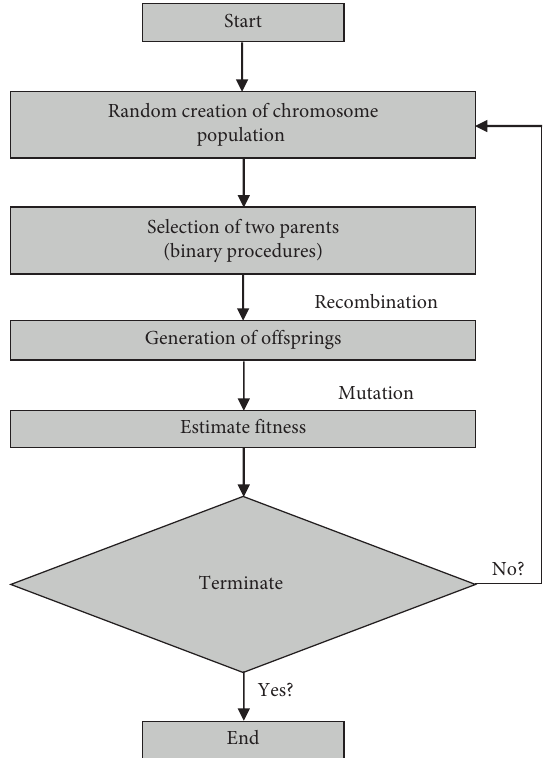
Figure 1: Schematic diagram of MEP technique.